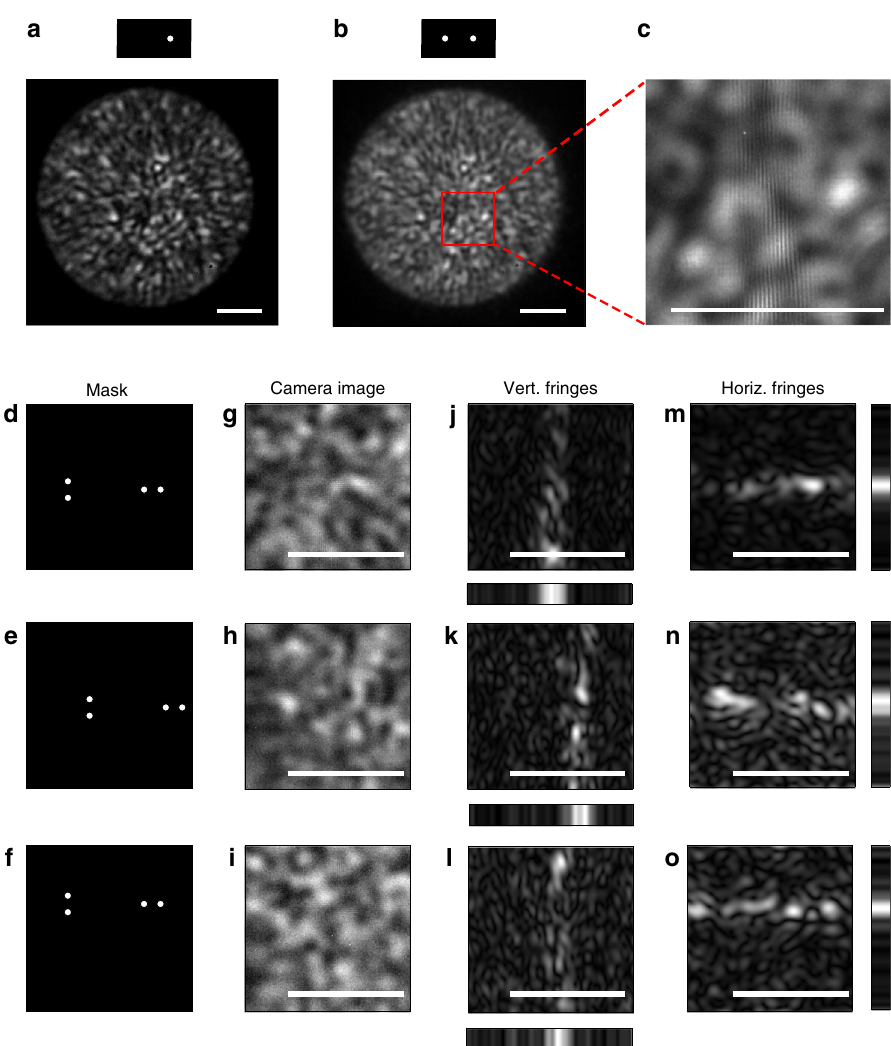
Fig. 2 Hidden source experimental TOF measurement through a diffusive barrier. a – c Raw camera images showing: a The speckle pattern measured for a mask with a single aperture (top). b For a double-aperture mask (top), localized interference fringes (highlighted by a red square) provide the TOF difference from the hidden source to the two apertures. c Zoom-in on ( b ). d – o Multiplexing elevation and horizontal information is accomplished using a mask with two pairs of apertures. 3D localization is obtained by shifting the mask for multiple TOF measurements: d – f Shifting the mask horizontally ( e ) and vertically ( f ) as imaged on the barrier. g – i Raw camera images for each mask position. j – l Vertical fringes envelope amplitude as detected by fi ltered Hilbert transform, providing the TOF difference between the two horizontally separated apertures (bottom: sum over rows). m – o Same as ( j – l ) for the horizontal fringes envelope amplitude (right: sum over columns). Scale bars: 100